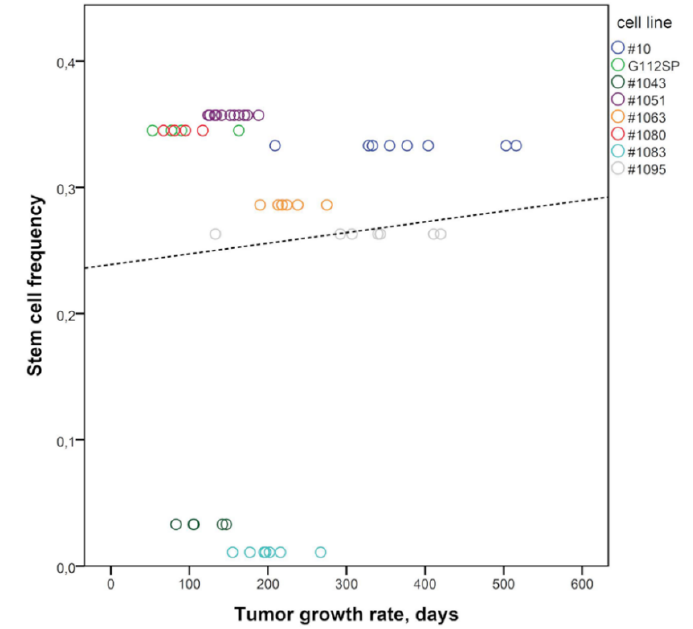
Figure 2. Lack of correlation between the frequency of self-renewing cells and rate of tumor growth driven by GSCs. Circles correspond to the time to individual mice death from a GSC-induced brain tumor. Different GSCs lines are color-coded. Pearson correlation analysis (r = 0.074, p = 0.60). Dotted line corresponds to the trend line.